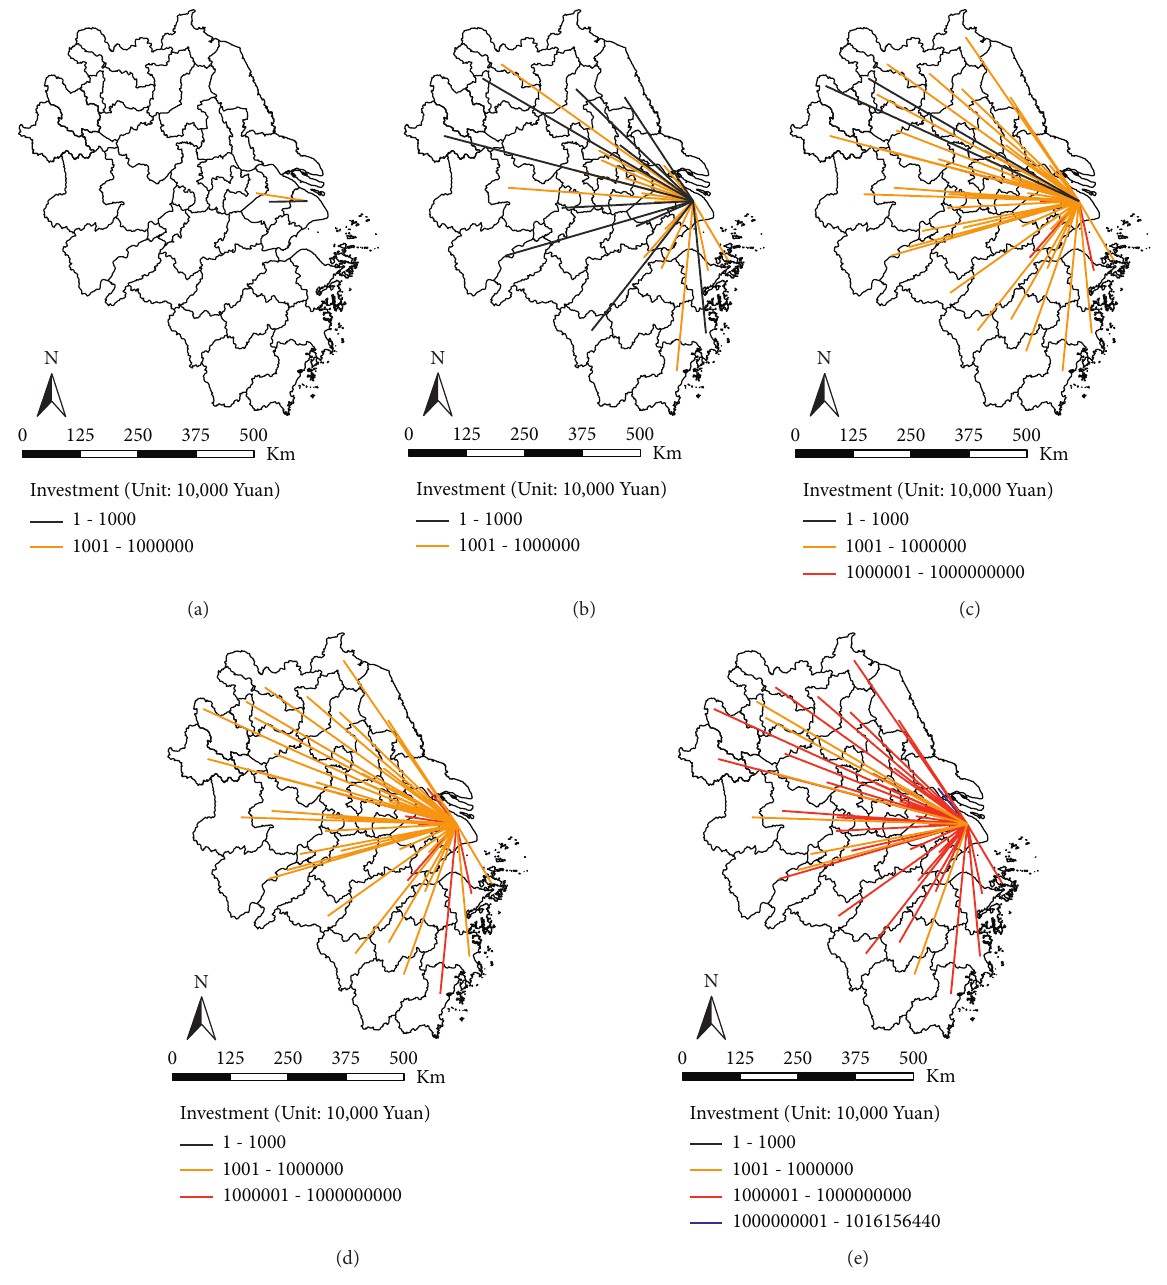
Figure 4: Enterprise investment linkages between Shanghai and hinterland cities. (a) 1978. (b) 1992. (c) 2003. (d) 2009. (e)